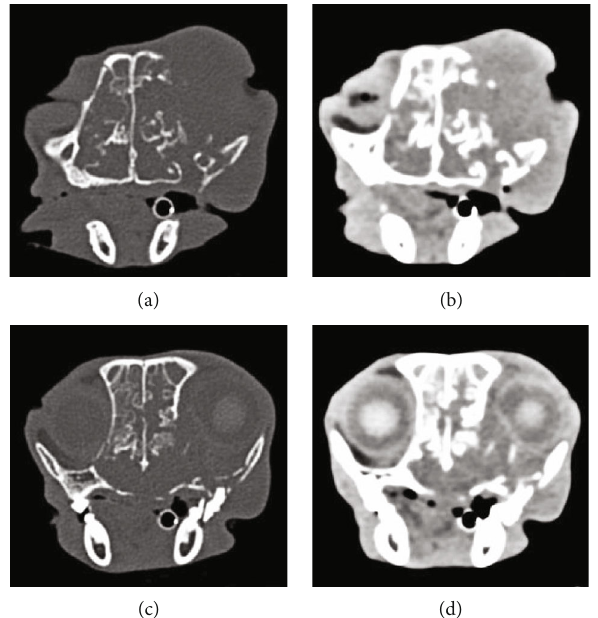
Figure 3: The CT images depict soft tissue (b, d) and bone window (a, c) images of the rostral (a, b) and caudal (c, d) portions of the tumor shown in Figure 1 prior to treatment with TOL. Note that the tumor involves and extends beyond the margins of the right orbit, invades the paranasal sinuses bilaterally, and perforates the hard palate extending into the oral